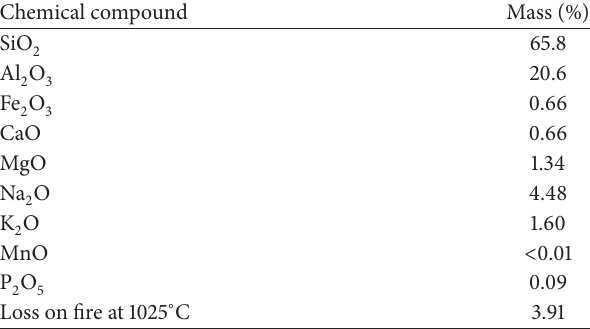
Table 1: Chemical analysis of spray-dried